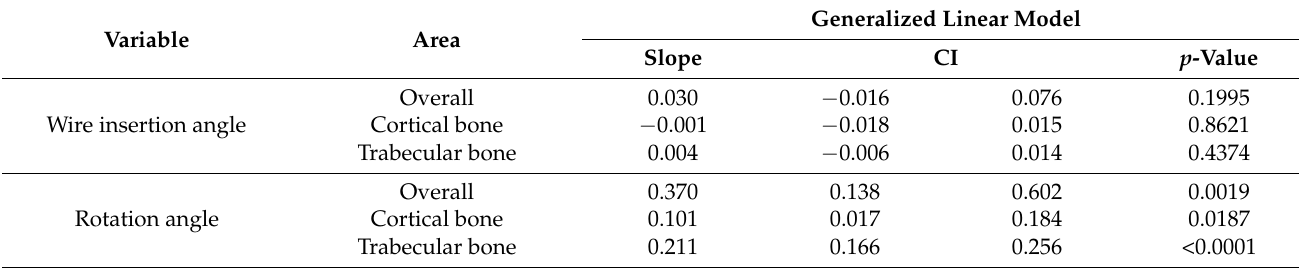
Table 7. Differences of moment between the centric hole group and eccentric hole group with the change of wire insertion angle and counter-clockwise rotation